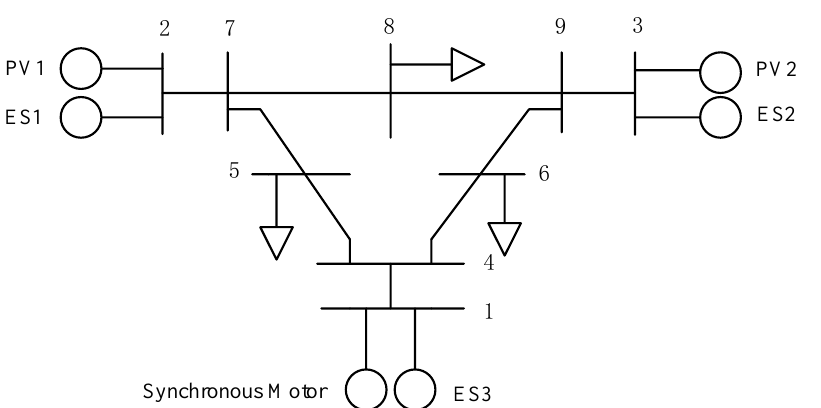
Figure 10. Example of the simulation system.